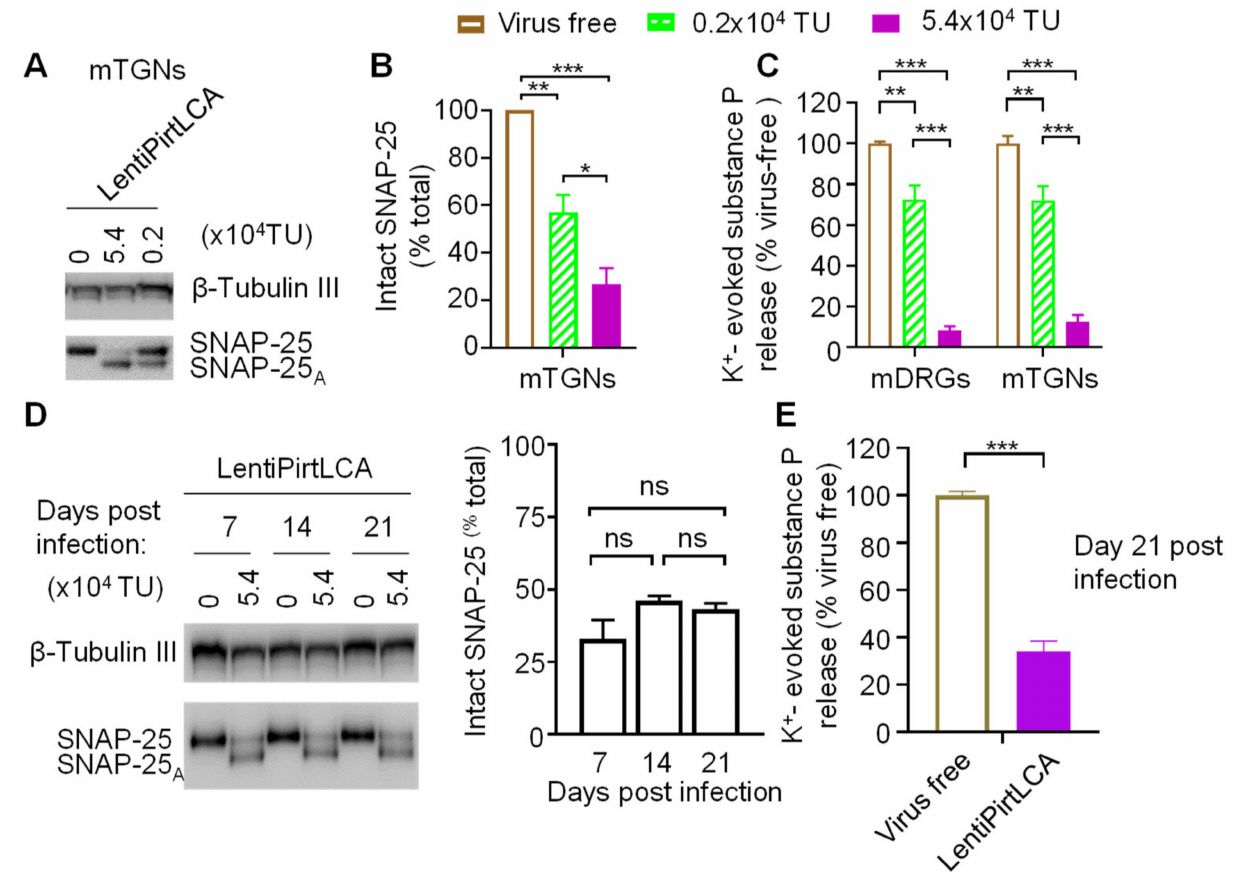
Figure 5. LentiPirtLCA yielded persistent cleavage of SNAP-25 and inhibition of K + -evoked substance P release from sensory neurons. ( A ) mTGNs were infected with lentiPirtLCA at the indicated doses for 5 days before probing the cleavage of SNAP-25. ( B ) The proportion of intact SNAP-25 remaining was calculated relative to the total (cleaved plus remaining intact). One-way ANOVA with Bonferroni’s multiple comparison test demonstrated significant differences between the groups: virus free vs. 0.2 × 10 4 TU p = 0.00598; virus free vs. 5.4 × 10 4 TU p = 0.00033; 0.2 × 10 4 TU vs. 5.4 × 10 4 TU p = 0.03006. ( C ) LentiPirtLCA inhibited K + -evoked substance P release from mDRGs and mTGNs. One-way ANOVA with Bonferroni’s multiple comparison test demonstrated significant differences between the groups in mDRGs: virus free vs. 0.2 × 10 4 TU p = 0.00107; virus free vs. 5.4 × 10 4 TU p < 0.00001; 0.2 × 10 4 TU vs. 5.4 × 10 4 TU p < 0.00001; in mTGNs: virus free vs. 0.2 × 10 4 TU p = 0.00333; virus free vs. 5.4 × 10 4 TU p < 0.00001; 0.2 × 10 4 TU vs. 5.4 × 10 4 TU p < 0.00001. ( D ) mDRGs were treated with lentiPirtLCA at 5.4 × 10 4 TU/well. At day 7, 14 and 21 post viral infection, cells were harvested for probing SNAP-25 cleavage. Western blot demonstrated viral mediated LCA expression induced persistent cleavage of SNAP-25 (left panel). Right panel, quantified data derived from densitometric scanning of 4 independent cultures. One-way ANOVA with Bonferroni’s multiple comparison test demonstrated no significant differences between the groups ( p > 0.05). ( E ) K + -evoked substance P release from LentiPirtLCA treated cells at day 21 after infection was normalized to the values obtained from virus-free control cells at day 21. Unpaired two-tailed Student’s t -test demonstrated LentiPirtLCA significantly inhibited substance P release ( p < 0.000001), even at day 21 after infection. Note that, considering neuronal loss during cultivation, cell seeding density in ( D , E ) are ~3-fold of that in C . Data presented are from at least three independent cultures. * p < 0.05; ** p < 0.01; *** p < 0.001, ns, p >